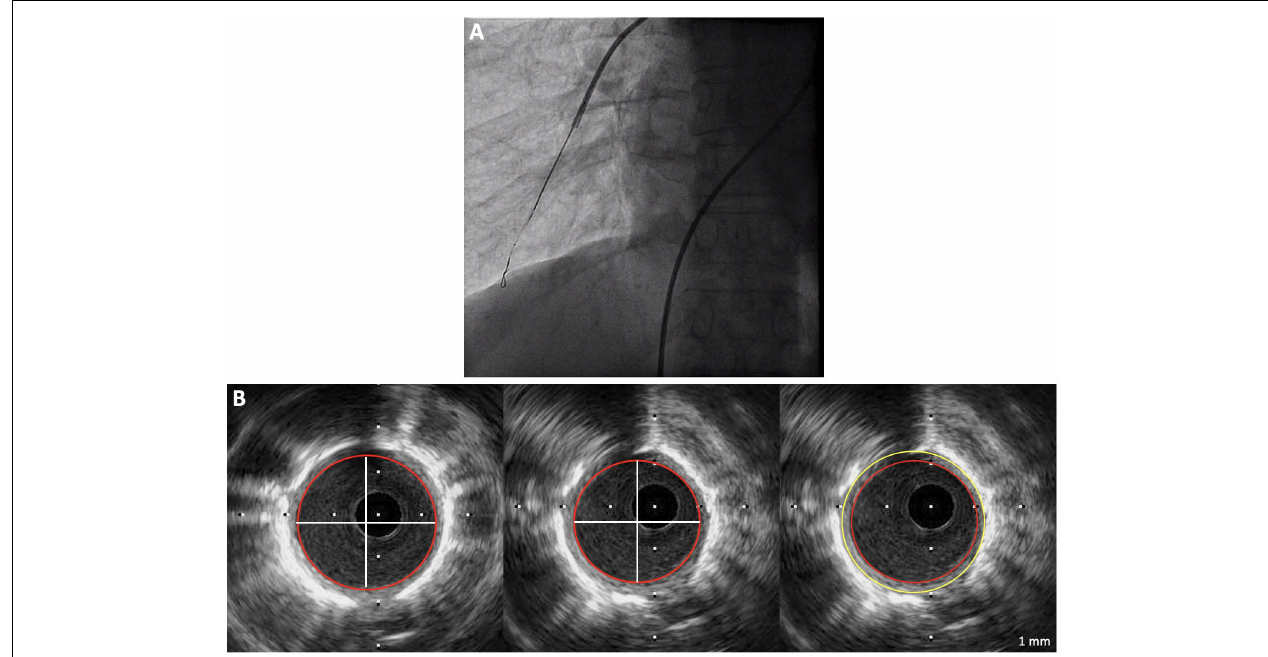
FIGURE 1 | (A) Intravascular ultrasound probe positioning with X-Ray control. (B) Measurements of maximum systolic area, minimum diastolic area, and wall cross-sectional area in a pulmonary arterial hypertension patient (Diameter: 2.8 mm; pulsatility 31%; WCSA: 4.6 mm 2 ; relative WCSA: